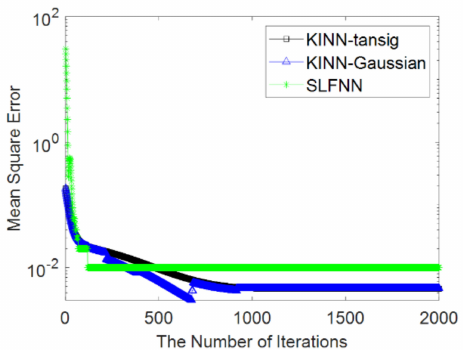
Figure 7. The training error (MSE) curves of KINN-tansig, KINN-Gaussian and SLFNN for the streak reservoir case. The black line with squares is the error curve of KINN-tansig; the blue line with triangles represents the error curve of KINN-Gaussian; and the green line with stars represent the error curve of